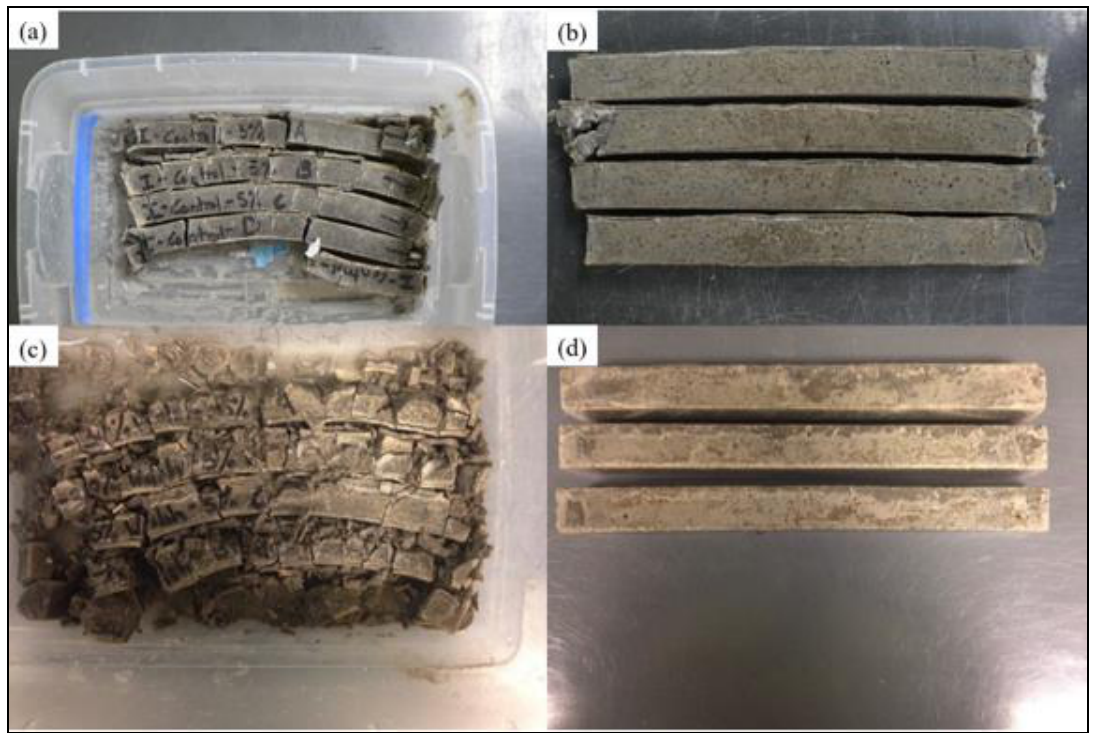
Figure 2. Visual appearance in mortar bars showing deterioration in: ( a ) C1 in 5% Na 2 SO 4 after 1 year; ( b ) C1 in 0.89% after 18 months; ( c ) C1 + 30%HC in 5% Na 2 SO 4 around 4 months; ( d ) C1 + 30%HC in 0.89% Na 2 SO 4 at 4 months.